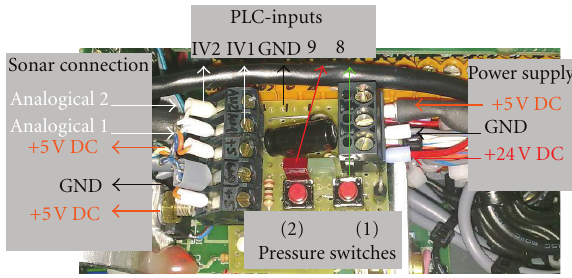
Figure 11: Local physical manual command interface over the adhesion and locomotion systems.